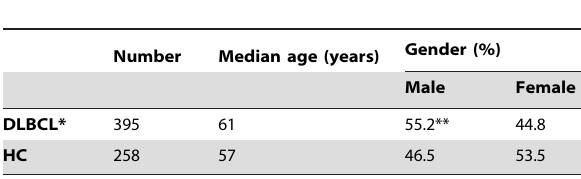
Table 1. Age and gender distribution of DLBCL patients and healthy